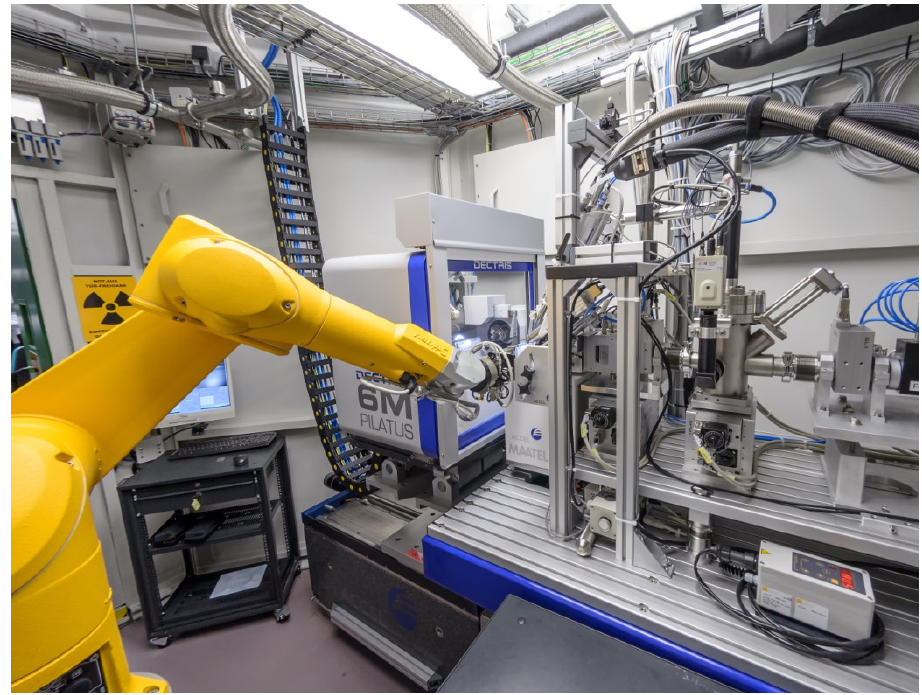
Figure 1: Experimental station of beamline